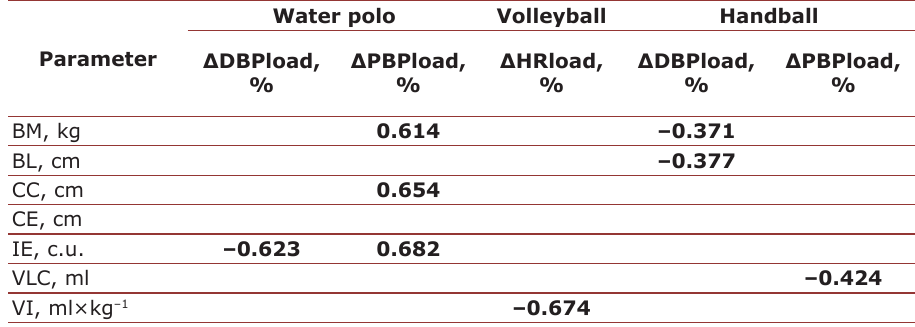
Table 4. Significant (p<0.05) correlations of indicators of the cardiovascular system reaction with indi - cators of athletes physical